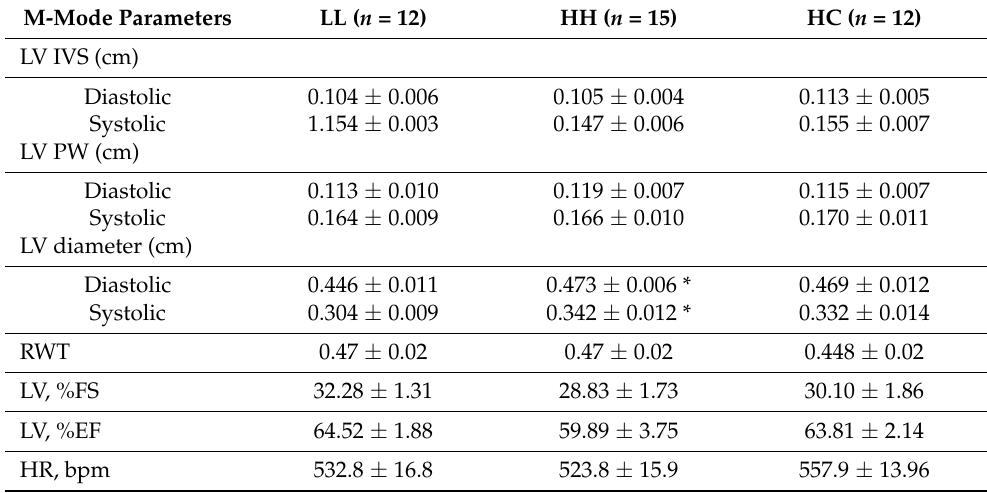
Table 2. Cardiac function assessed by Echocardiography in 5–6-month-old male